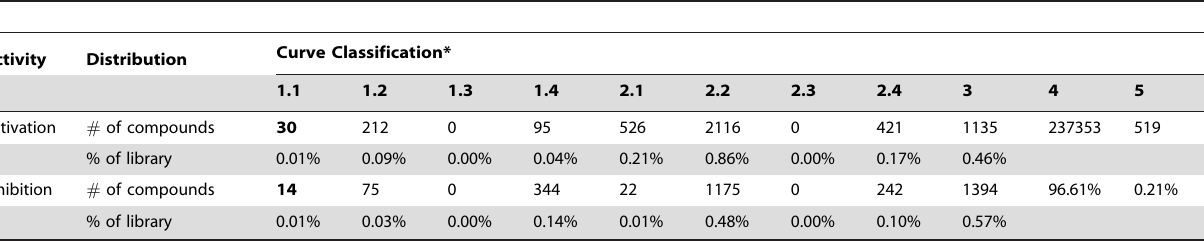
Table 1. Classification of active compounds identified from the screen assay using the N370S mutant enzyme in spleen tissue.